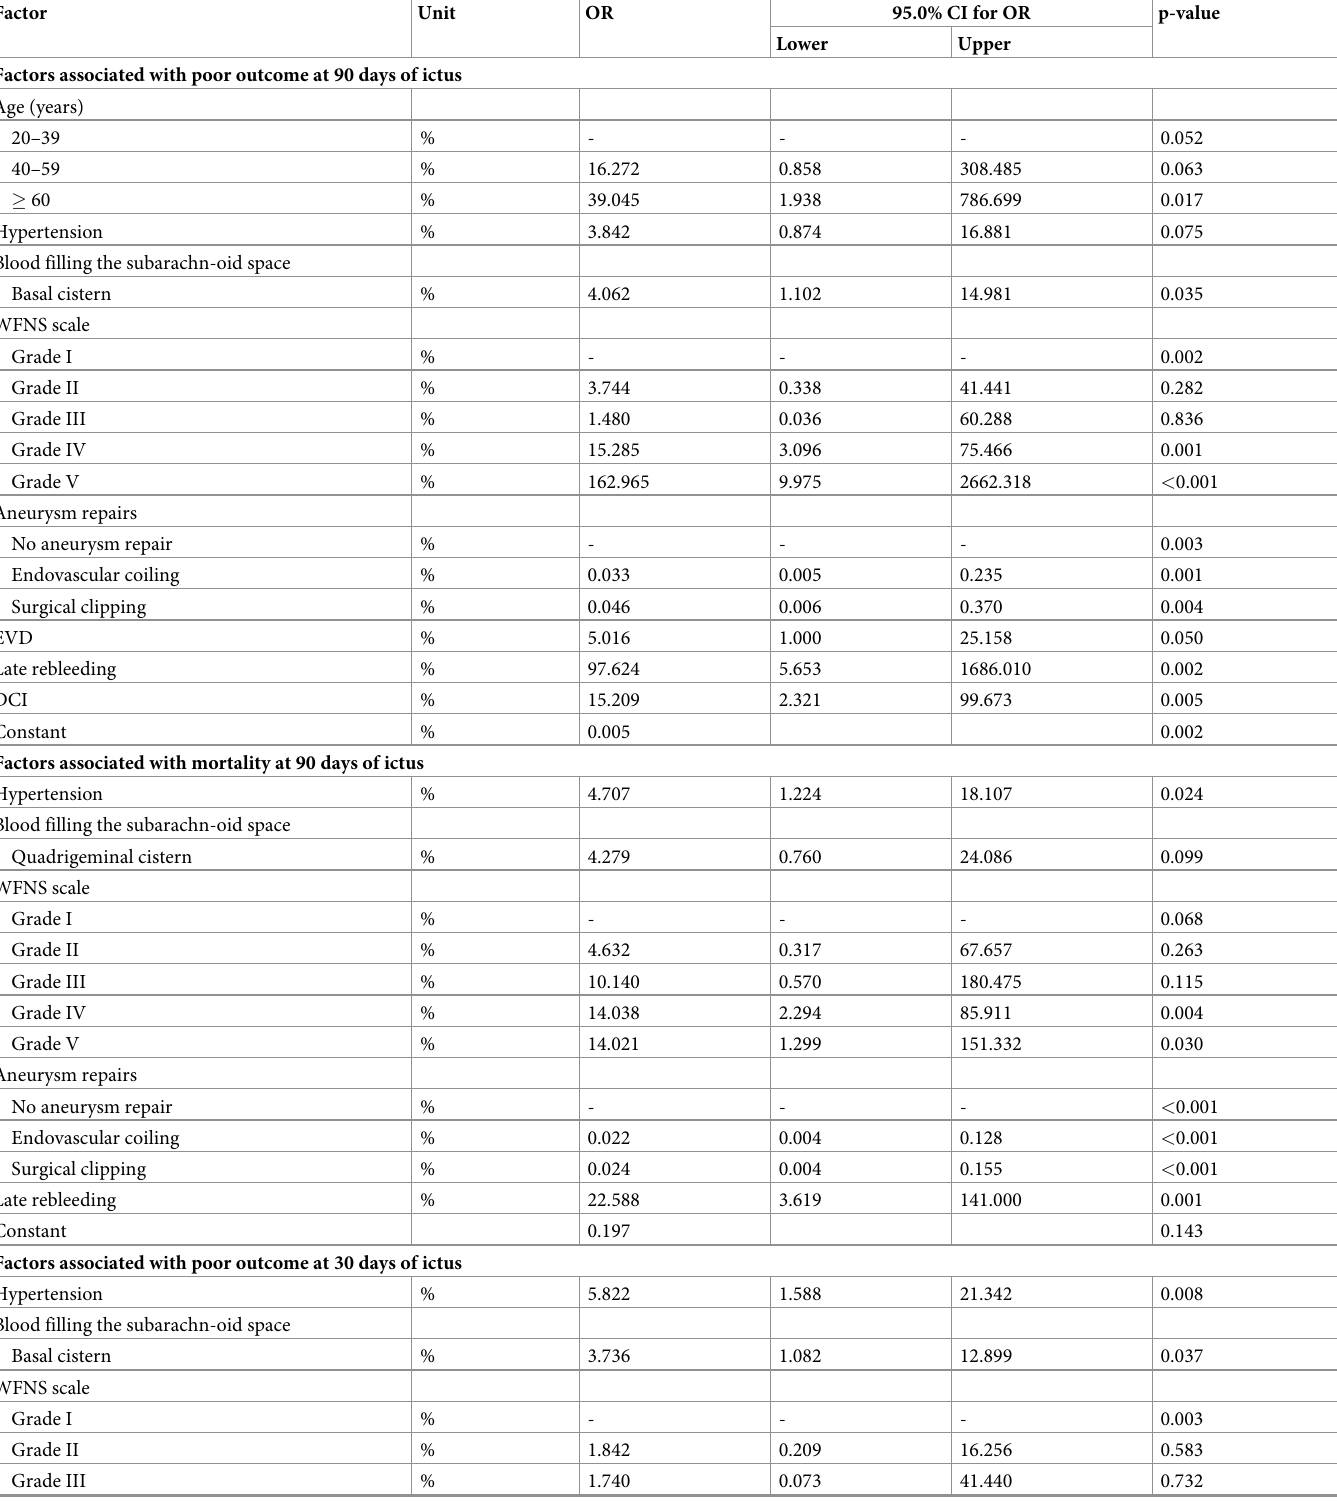
Table 3. Factors associated with poor outcome and mortality of patients with aneurysmal subarachnoid hemorrhage: Multivariate logistic regression